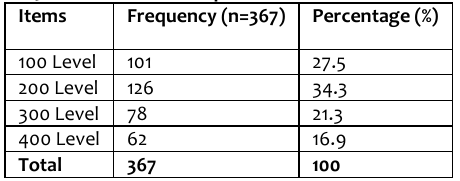
Table 5: Distribution of Respondents Based on Class Level Items